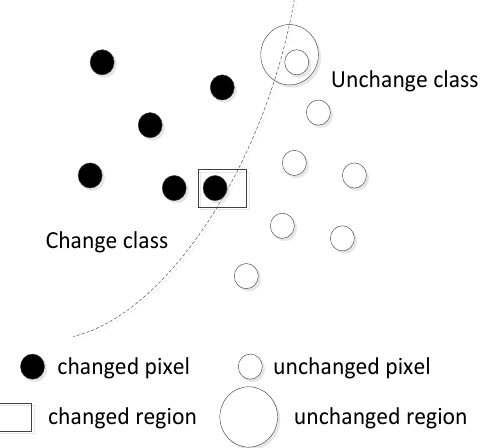
Figure 1. Illustration of the relationship between pixels and their context.